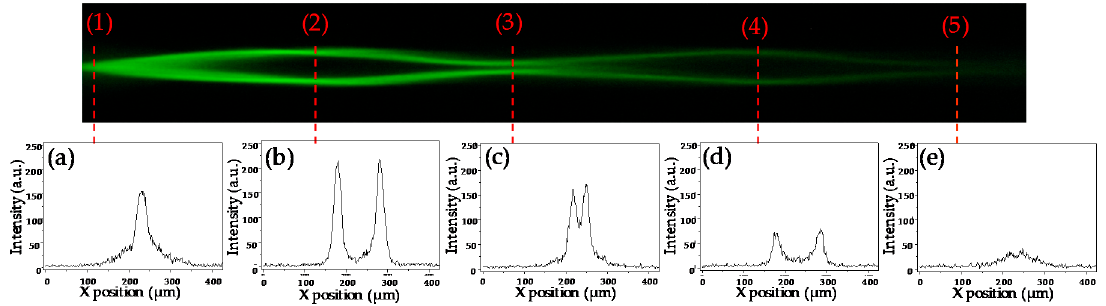
Figure 7. Captured image of the laser beam and corresponding intensity distributions at ( a ) z = 0 mm, ( b ) z = 0.8 mm, ( c ) z = 1.5 mm, ( d ) z = 2.3 mm, and ( e ) z = 2.8 mm, respectively, with the applied voltage of 2.1 V.